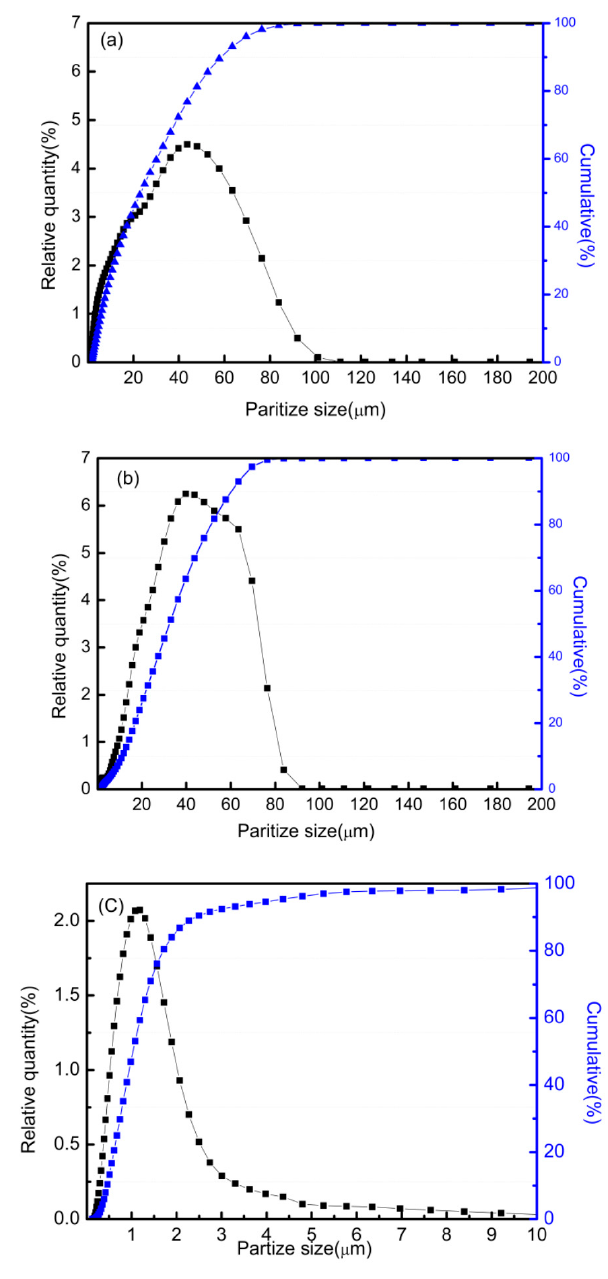
Figure 4. Particle size distribution of the composite powder ( a ) before milling; ( b ) after milling and ( c ) MnZn(Fe 2 O 4 ) 2 powders.